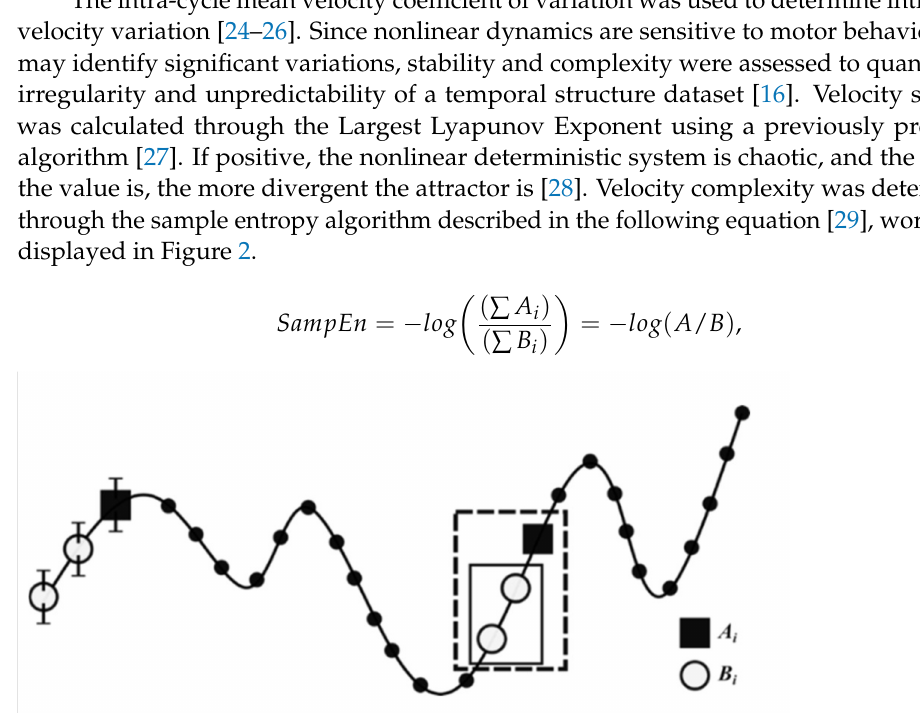
Figure 2. Schematic demonstration of entropy estimation using sample entropy, with the time series beginning with the i th template. A i = number of matches of length m + 1 with i th template and B i = number of matches of length m with i th template. The parameter m is 2 and the tolerance for accepting matches is r = 0.2 times the SD (error bars). The template is matched by the 16 and 17th points (solid box), and the m + 1st points also match (dashed box). Therefore, A and B increase by